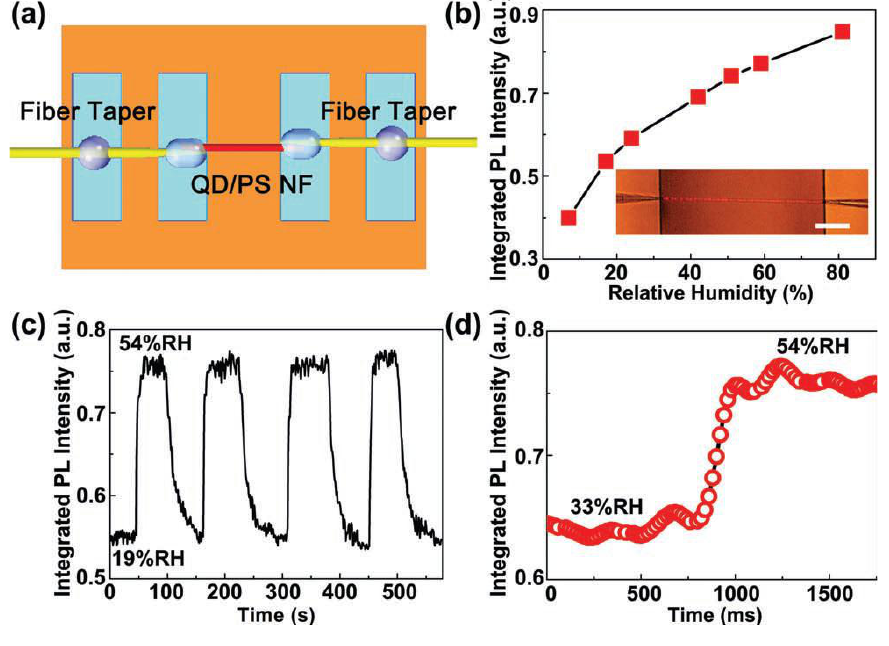
Figure 18. QD-doped microfiber optical sensor [30]. ( a ) Schematic illustration of a QD-doped PS microfiber optical sensor; ( b ) PL intensity of the microfiber exposed to ambient relative humidity (RH) ranging from 7% to 81%. Inset, optical microscopy image of the QD-doped microfiber sensing element. Scale bar: 50 μm; ( c ) Response of the MF sensor to alternately cycled 54% and 19% RH air; ( d ) Typical time-dependent integrated PL intensity of the microfiber reveals a response time of about 90 ms when RH jumps from 33% to